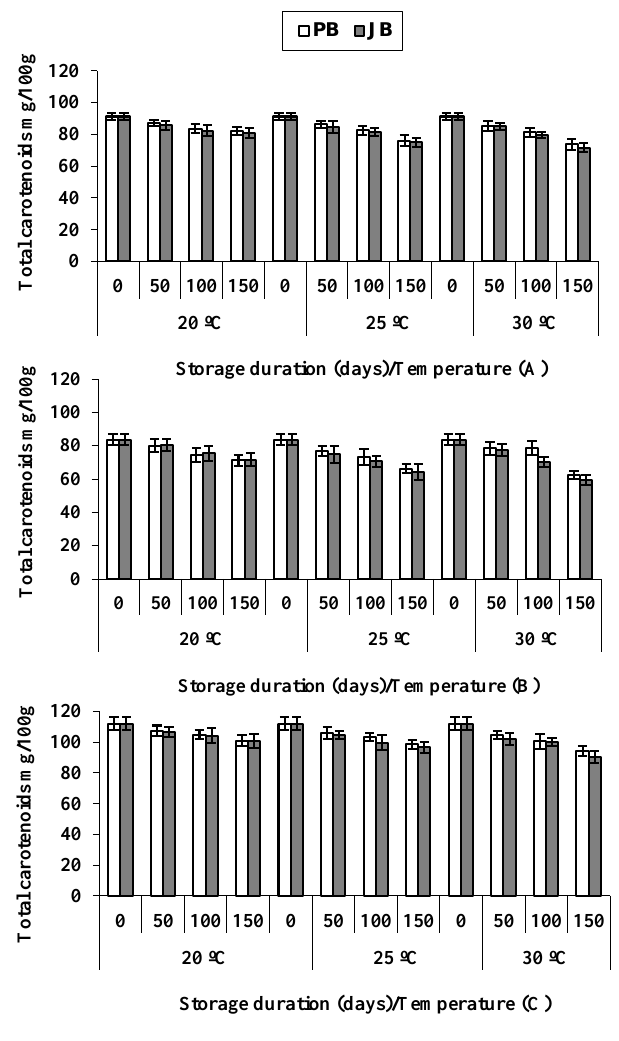
Figure 2. Total carotenoids in hot peppers viz . Sky Red ( A ), Maha ( B ) and Wonder King ( C ) at different temperatures and packaging materials during five months’ storage. Vertical bars show ± SD of n = 3